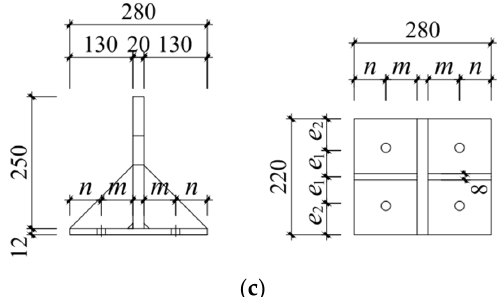
Figure 1. Schematic diagram of T-stub parameters: ( a ) T1~T5; ( b ) T6; ( c ) T7.